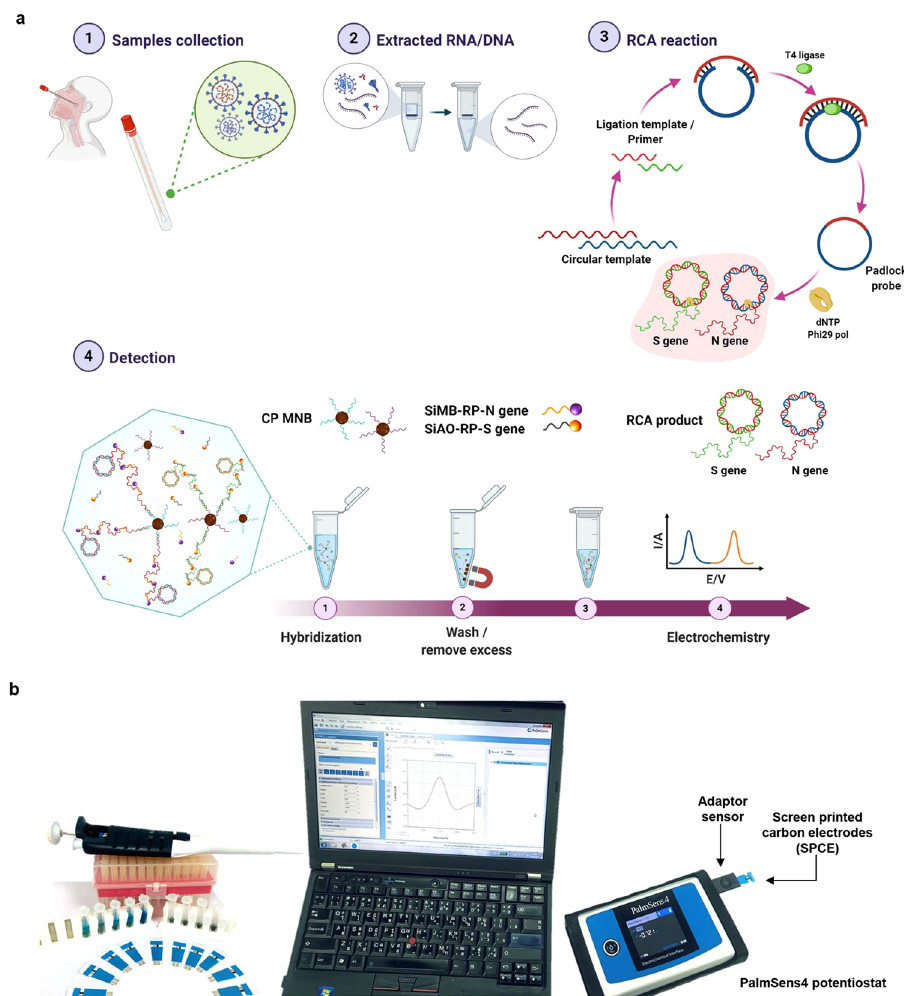
Fig. 1 Overview of the detection platform. a Detection work fl ow of SARS-CoV-2 from clinical samples using the electrochemical biosensor with RCA of the N and S genes. b The detection setup for electrochemical analysis by using a portable potentiostat device connected to a attributed to the same mechanism of the redox reaction (two- electron oxidation) for both dyes used in this study (Supplemen- tary Fig. 2) 28,32 . The detection limit of both the N and S genes correlation of current signal for N and S genes was 99%. The plasmid concentrations in molarity are shown in Supplementary